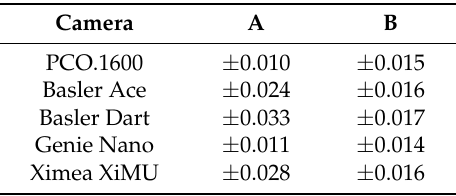
Table 5. Uncertainty estimation per